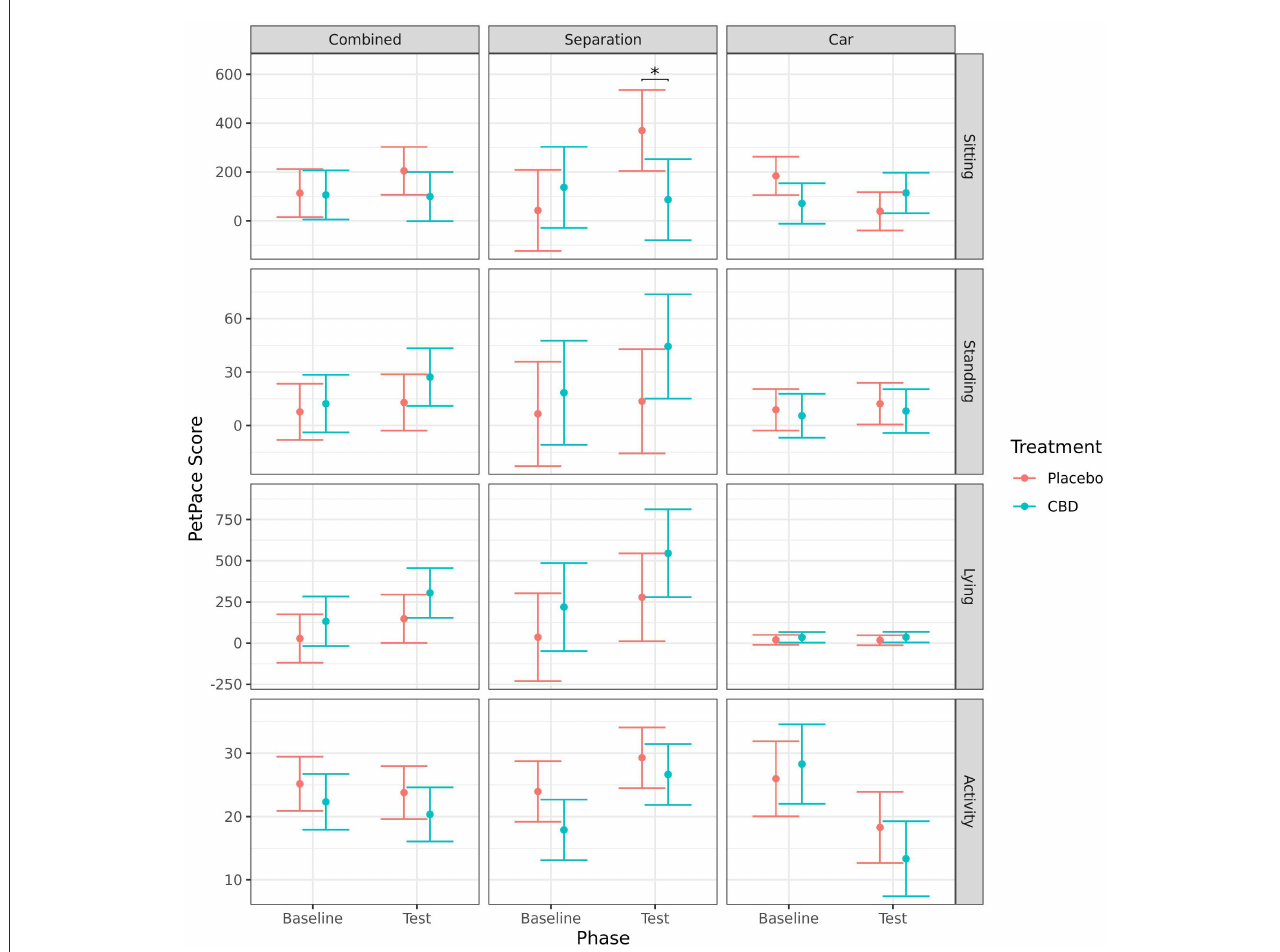
FIGURE9 Predicted mean (95% CI) “sitting,” “standing,” “lying,” and “activity” scores generated by the PetPace TM device for dogs given CBD or placebo at each phase of testing (baseline and test) based on models analyzing both stress tests combined, separation test or car test. Asterisks indicate significant differences between treatment groups within each phase. * p <